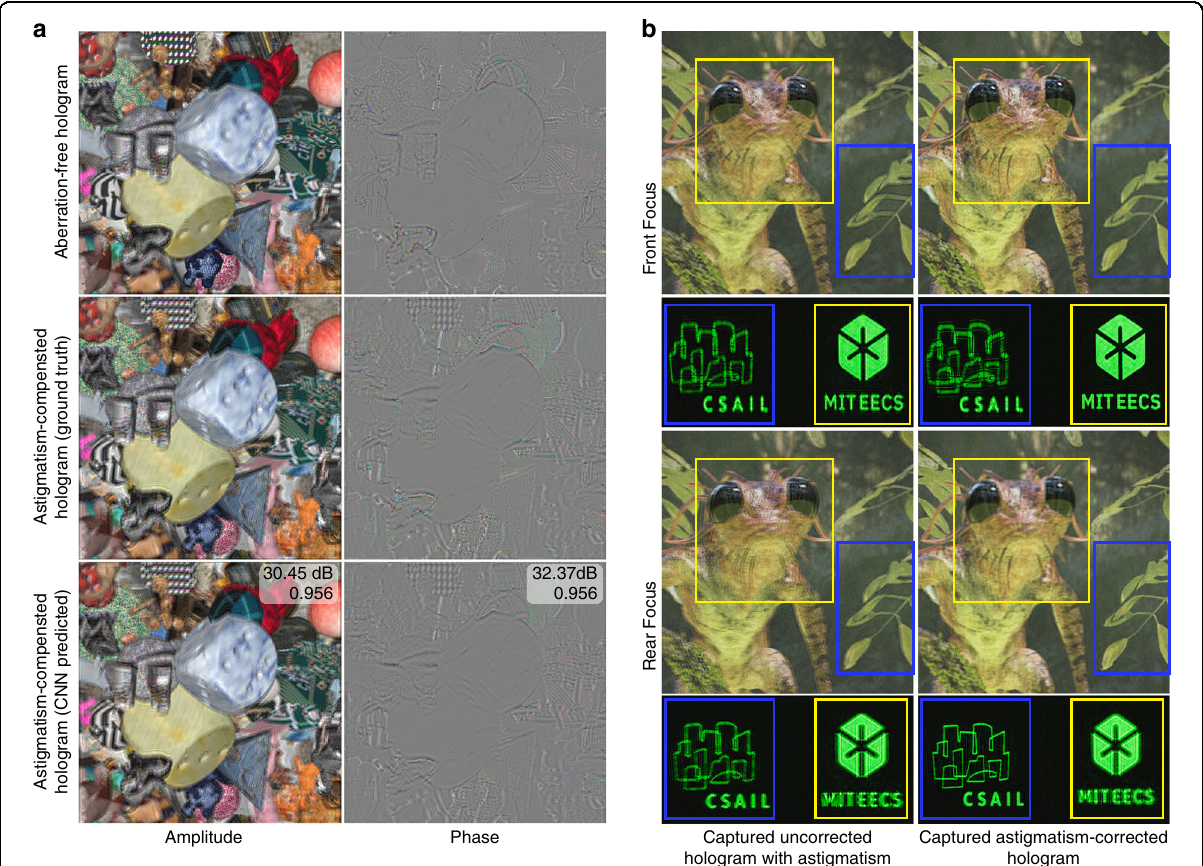
Fig. 8 Performance evaluation of vision aberration correction. a Top: A hologram calculated for normal vision. Middle: A hologram calculated using the proposed variant of SM-LBM that corrects a synthetic astigmatic vision induced by a 200 mm cylindrical lens. The calibration method is detailed in Methods. Bottom: The CNN trained on the astigmatism-corrected dataset jointly performs diffraction simulation and aberration correction. The PSNR and SSIM of the predicted hologram are marked on the top right corner. b Experimentally captured CNN-predicted holograms of a natural scene and a test scene without (Left) and with (Right) astigmatism correction. The yellow and the blue box marks the foreground and the background object of interest, respectively. The in-focus object in the corrected hologram exhibits horizontal blurs in the uncorrected hologram (i.e., treefrog ’ s tentacles, eye re fl ections, tree leaves, and test